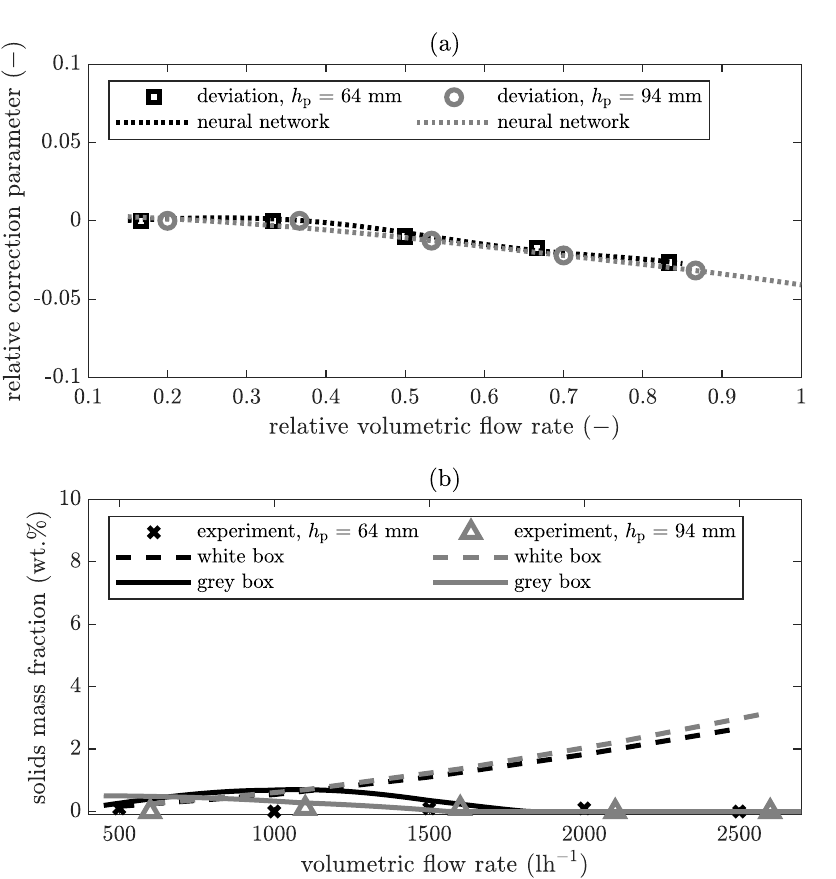
Figure 10. Solids mass fraction of the centrate at a constant rotational speed of n rot = 2950rpm for the product CC2: ( a ) relativised output of the black box model, ( b ) comparison of the results from experiment, white, and grey box